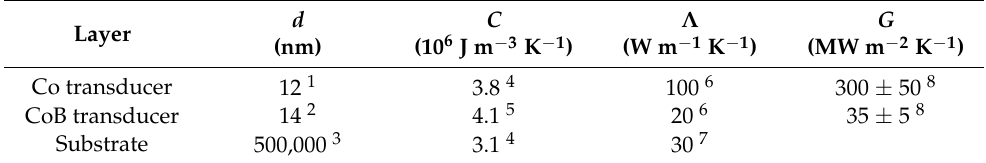
Table 1. Thermodynamic properties for thermal analysis in Figure 6. The film structure is a sapphire substrate/metal (Co or CoB) transducer, which is presented with the thickness ( d ), heat capacity ( C ), and thermal conductivity ( Λ ) of each layer, and the thermal conductance ( G ) at the interface. Λ d C G Layer (nm) (10 6 J m − 3 K − 1 ) (W m − 1 K − 1 ) (MW m − 2 K − 1 ) Co transducer 12 1 3.8 4 100 6 300 ± 50 8 CoB transducer 14 2 4.1 5 20 6 35 ± 5 8 Substrate 500,000 3 3.1 4 30 7 1 For the Co(10 nm)/Pt(2 nm) structure. 2 For the Co 3 When it is thicker than 50 B 50 (10 nm)/Pt(4 nm) structure. the heat penetration depth, the thickness of the substrate does not affect the thermal analysis. 4 [41]. 5 [42]. 6